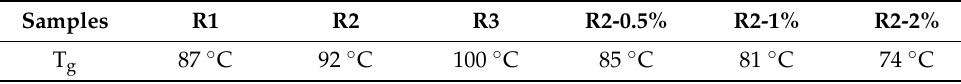
Table 2. T g value of different samples.